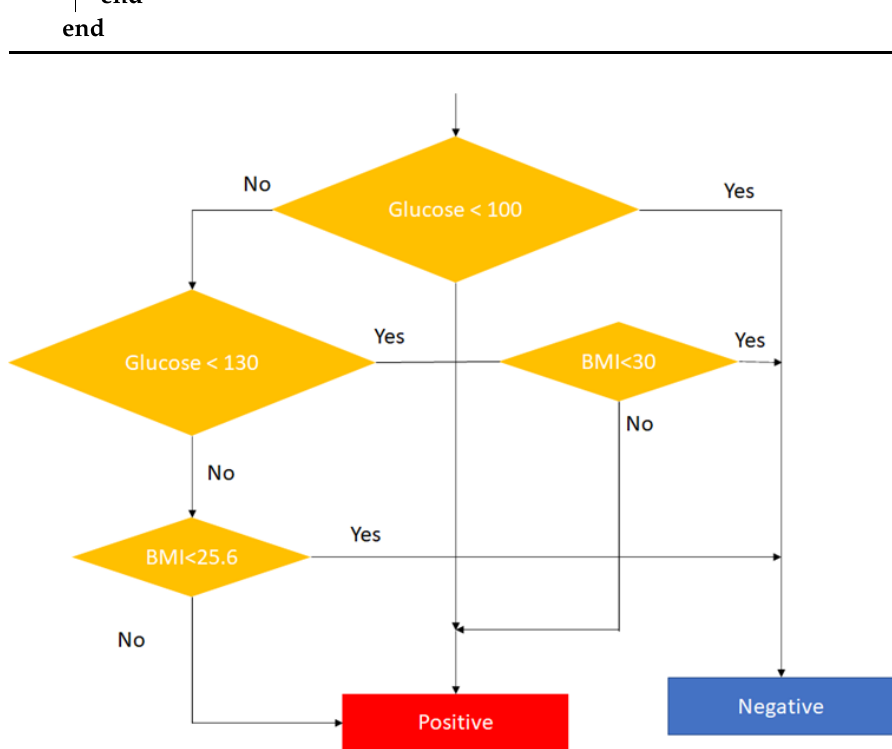
Figure 2. The flow diagram of ID3